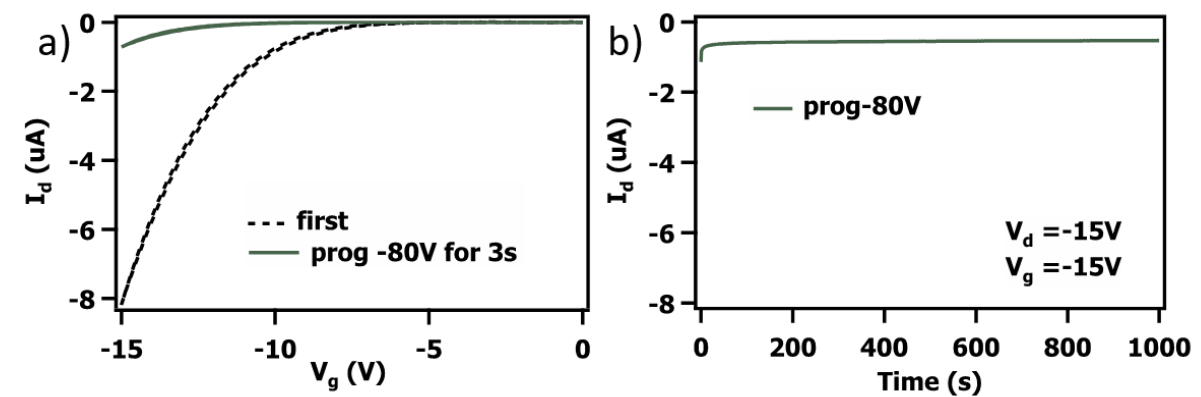
Figure 4. ( a ) Transfer curves of the pentacene-based OTFTs with PS electret before and after programming by applying the − 80 V gate bias for 3 s; ( b ) the stability of the drain current after programming with negative − 80 V gate bias for 3 s measured at V d = − 15 V, V g = − 15 V. ‘First’ refers to the I–V curve in the absence of programming and ‘prog’ refers to the I–V curve following the programming at − 80 V for 3 s.